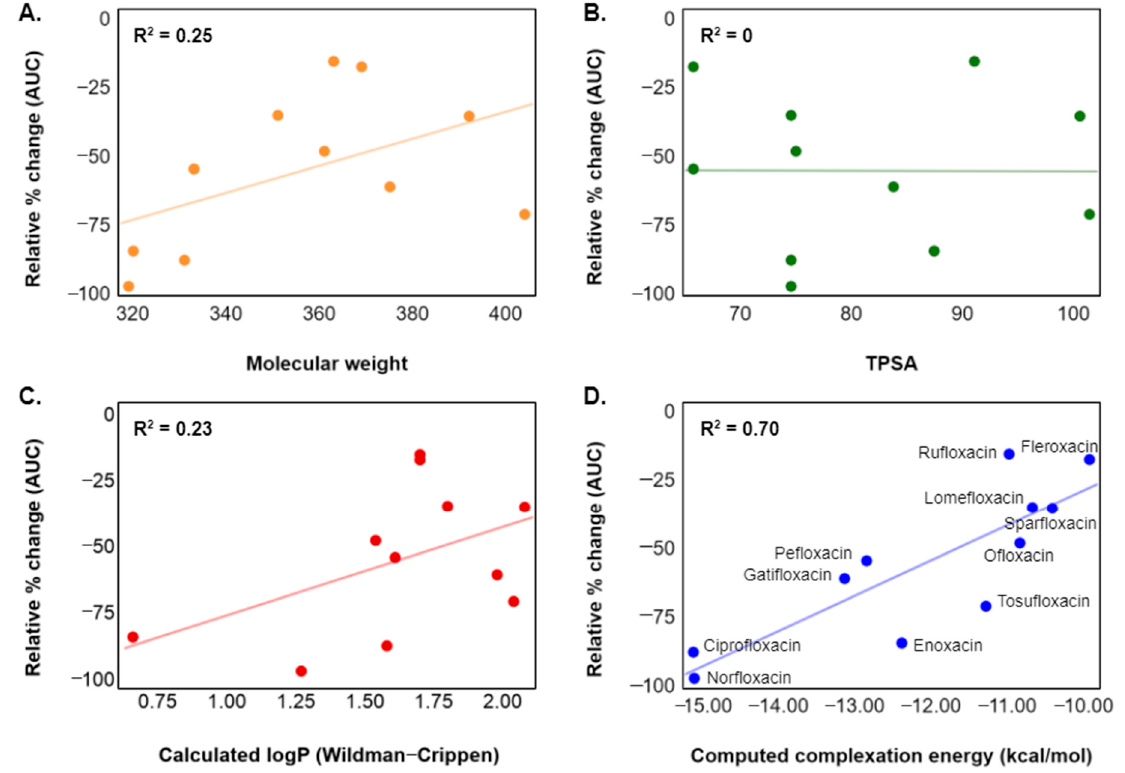
Figure 3. Plots of relative percent change in bioavailability (AUC) versus ( A ) molecular weight, ( B ) topological polar surface area (TPSA) [45], ( C ) predicted log P from chemical structure (Wildman–Crippen model) [46], and ( D ) computed complexation energy ( Δ E bind ) to aluminum hexahydrate. Changes in AUC on the y -axis are from FQ coadministration with aluminum hydroxide [71] or Maalox.